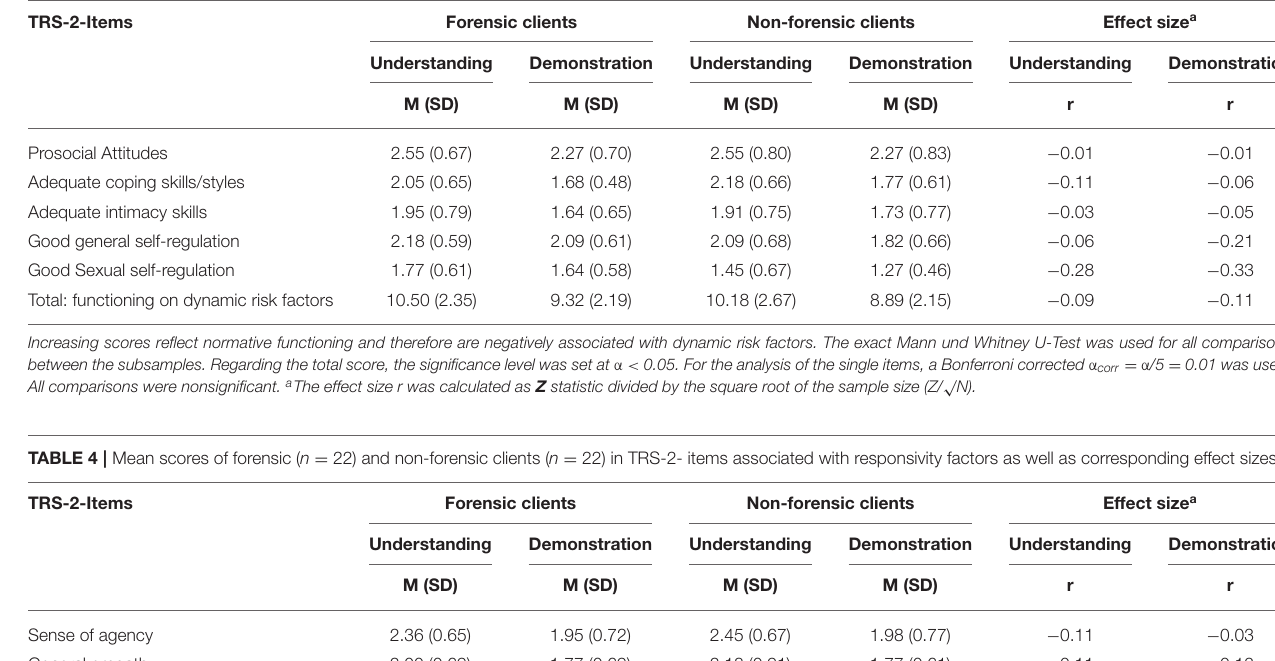
22) in TRS-10- items associated with dynamic risk as well as corresponding effect sizes. =